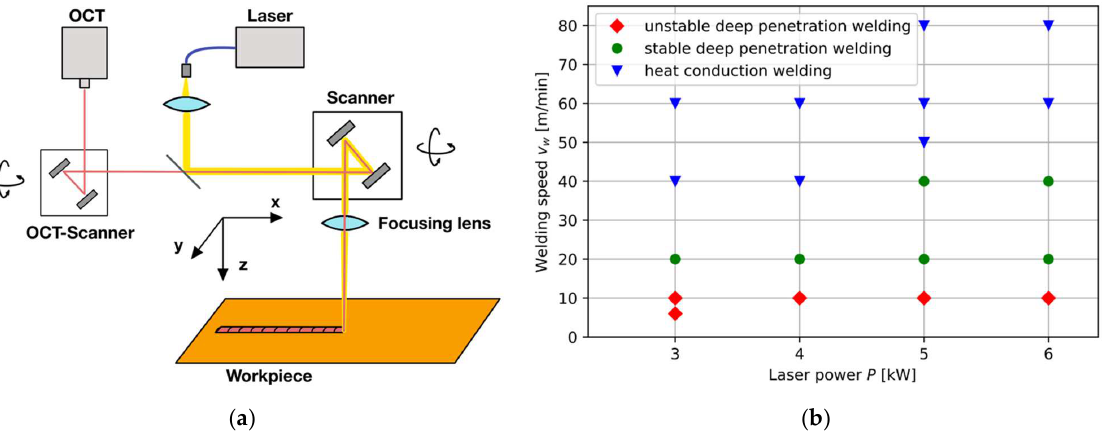
Figure 1. ( a ) Schematic experimental setup with OCT, processing laser, programmable focusing optics, and workpiece; ( b ) Overview of laser welding parameters depending on weld category (unstable deep penetration welding (red), stable deep penetration welding (green), heat conduction welding (blue).